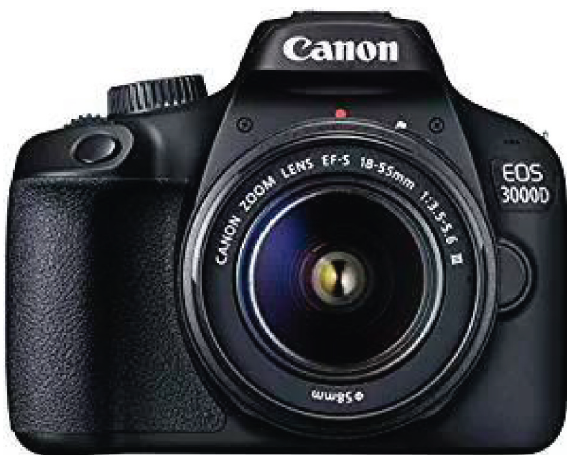
Figure 3: Features of Canon SLR EOS 3000D 18MP digital